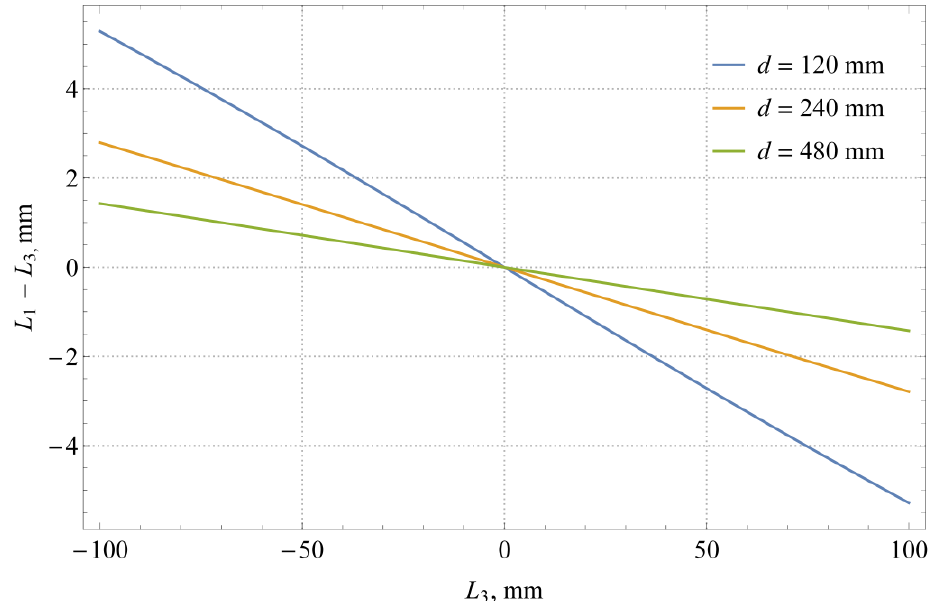
Figure 2. Magnitude of the parallax effect L 1 − L 3 (simulation made for d s = 5 mm, d g = 3 mm, and n 2 / n 1 = 1.52).